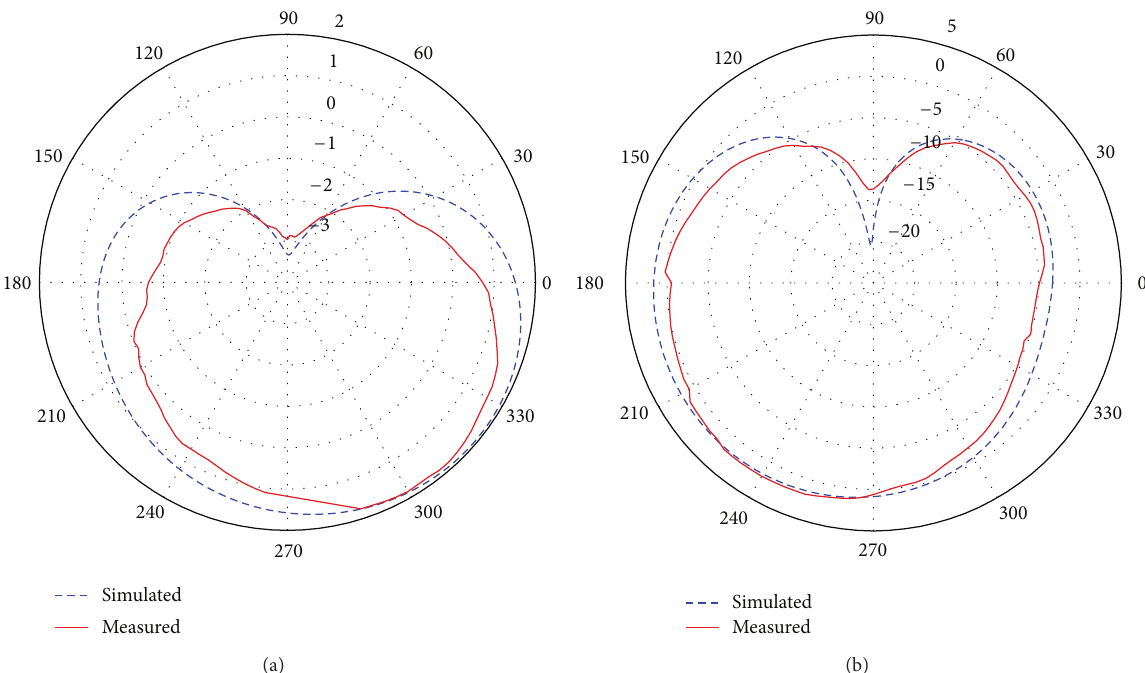
Figure 17: Comparison of numerical and experimental gain pattern cuts at 2.6 GHz recorded at the principal planes (a) 𝜙 = 0 and (b) 𝜃 = 𝜋/2 . Notice the different radial scales (both are given in dBi).